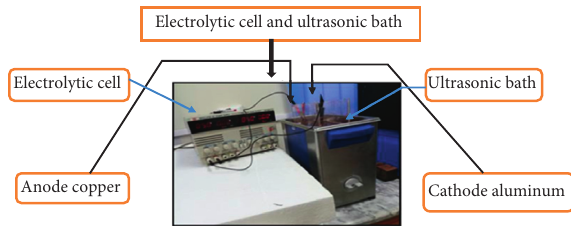
Figure 2: Sonoelectrolytic reactor. It is a combination of elec- trolytic cell and ultrasonic